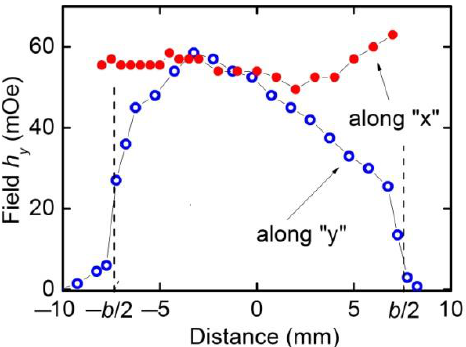
Figure 13. Measured distributions of excitation field h y along and across the direction of the current in a “magnetic capacitor” for I = 80 mA. Curve along “ x ” is for y = 0 and z = 0, and curve along “ y ” is for x = 0 and z = 0.